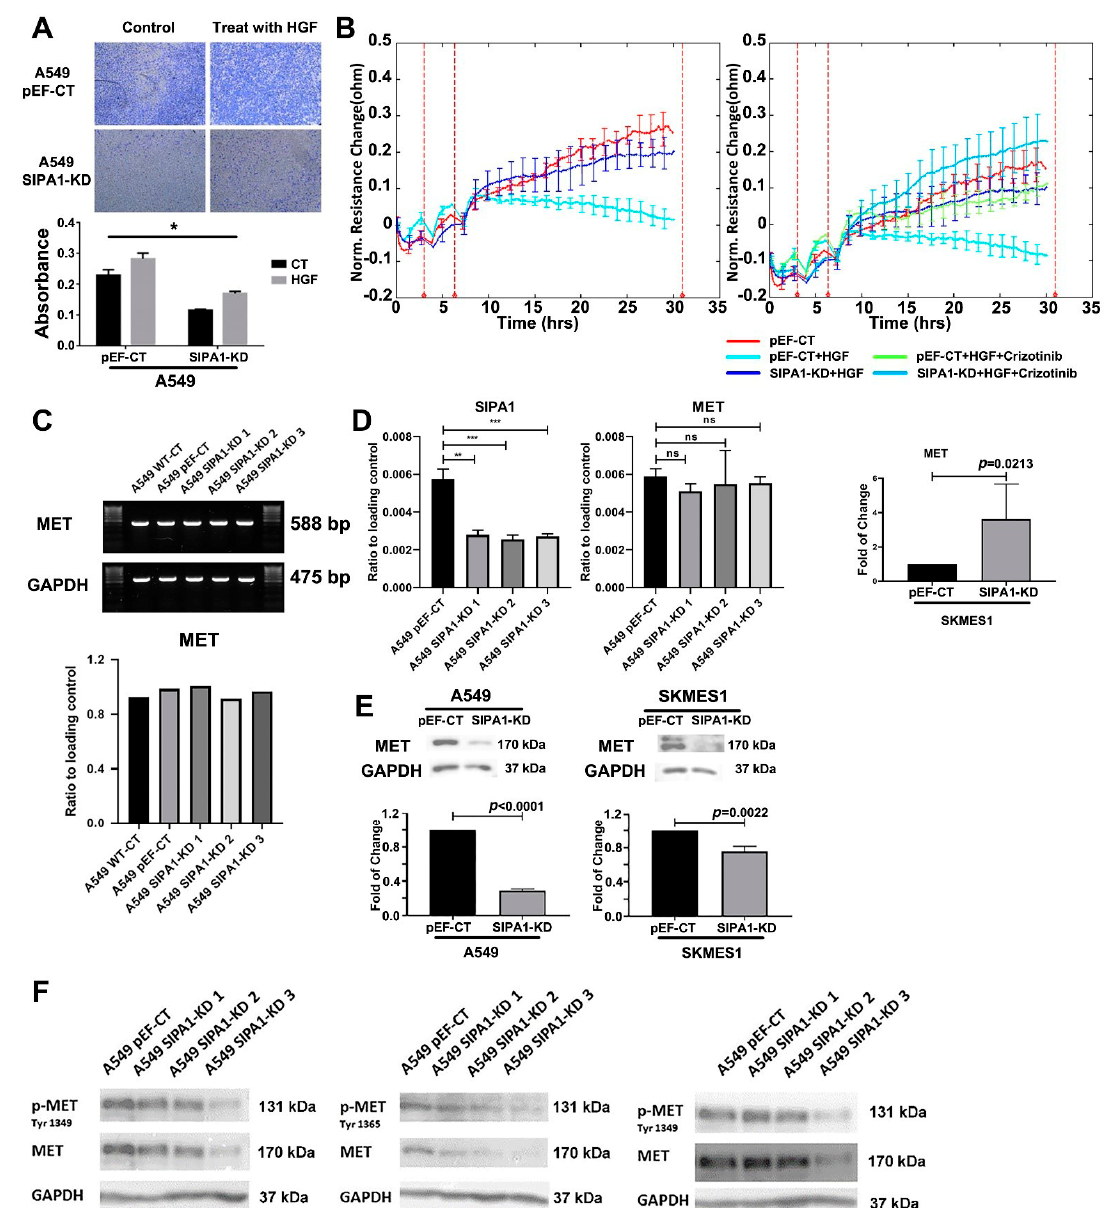
Figure 6. SIPA1 and HGF/MET signaling on the regulation of TJs in lung cancer cells. ( A ) HGF increased the invasion potential of pEF-CT A549 cells, and knockdown of SIPA1 decreased invasion in A549 pEF cells with/without the treatment of HGF. ( B ) HGF decreased resistance of A549 pEF-CT cells significantly but did not decrease resistance of A549 SIPA1 knockdown cells (left), indicating the regulation of HGF on TJs requires the assistance of SIPA1. The effect that HGF decreased resistance of A549 pEF-CT cells instead of A549 SIPA1-KD cells produced a similar result as that achieved when using the MET inhibitor (Crizotinib), and the combination of SIPA1 knockdown and MET inhibitor could further prevent regulation of HGF on A549 cells (right), all of which revealed that silencing SIPA1 has the same cellular influence on A549 cells as blocking HGF/MET signaling by Crizotinib. ( C , D ) The mRNA level of MET was not regulated by the knockdown of SIPA1 in lung cancer cell lines examined using PCR ( C ) and QPCR ( D ). ( E ) Western blot showing the protein level of MET was down regulated by knockdown of SIPA1 in A549 and SKMES1 lung cancer cell lines. ( F ). The phosphorylation level of MET was down regulated by knockdown of SIPA1 in A549 lung cancer cell lines which would be due to the reduction in total MET protein expression. Experiments were repeated n = 3. *, **, *** indicate statistical